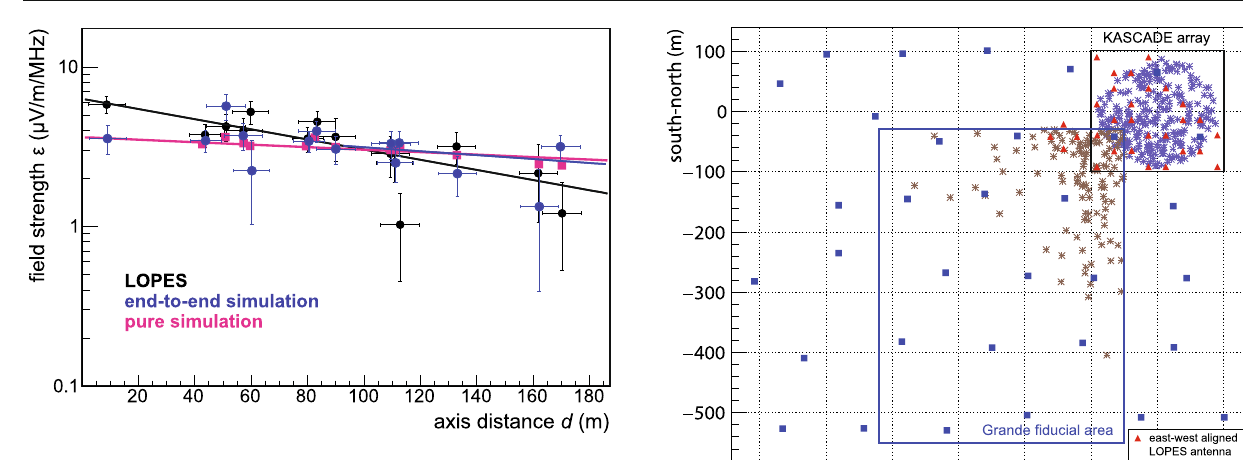
Fig. 7 Lateral distribution of a typical example event measured by LOPES and simulated with CoREAS. The application of the detec- tor response (= end-to-end) impacts the CoREAS simulations only marginally. Generally, a different slope for the simulated and measured lateraldistributionisexpectedforindividualeventsbecausetheposition of the shower maximum is subject to shower-to-shower fluctuation